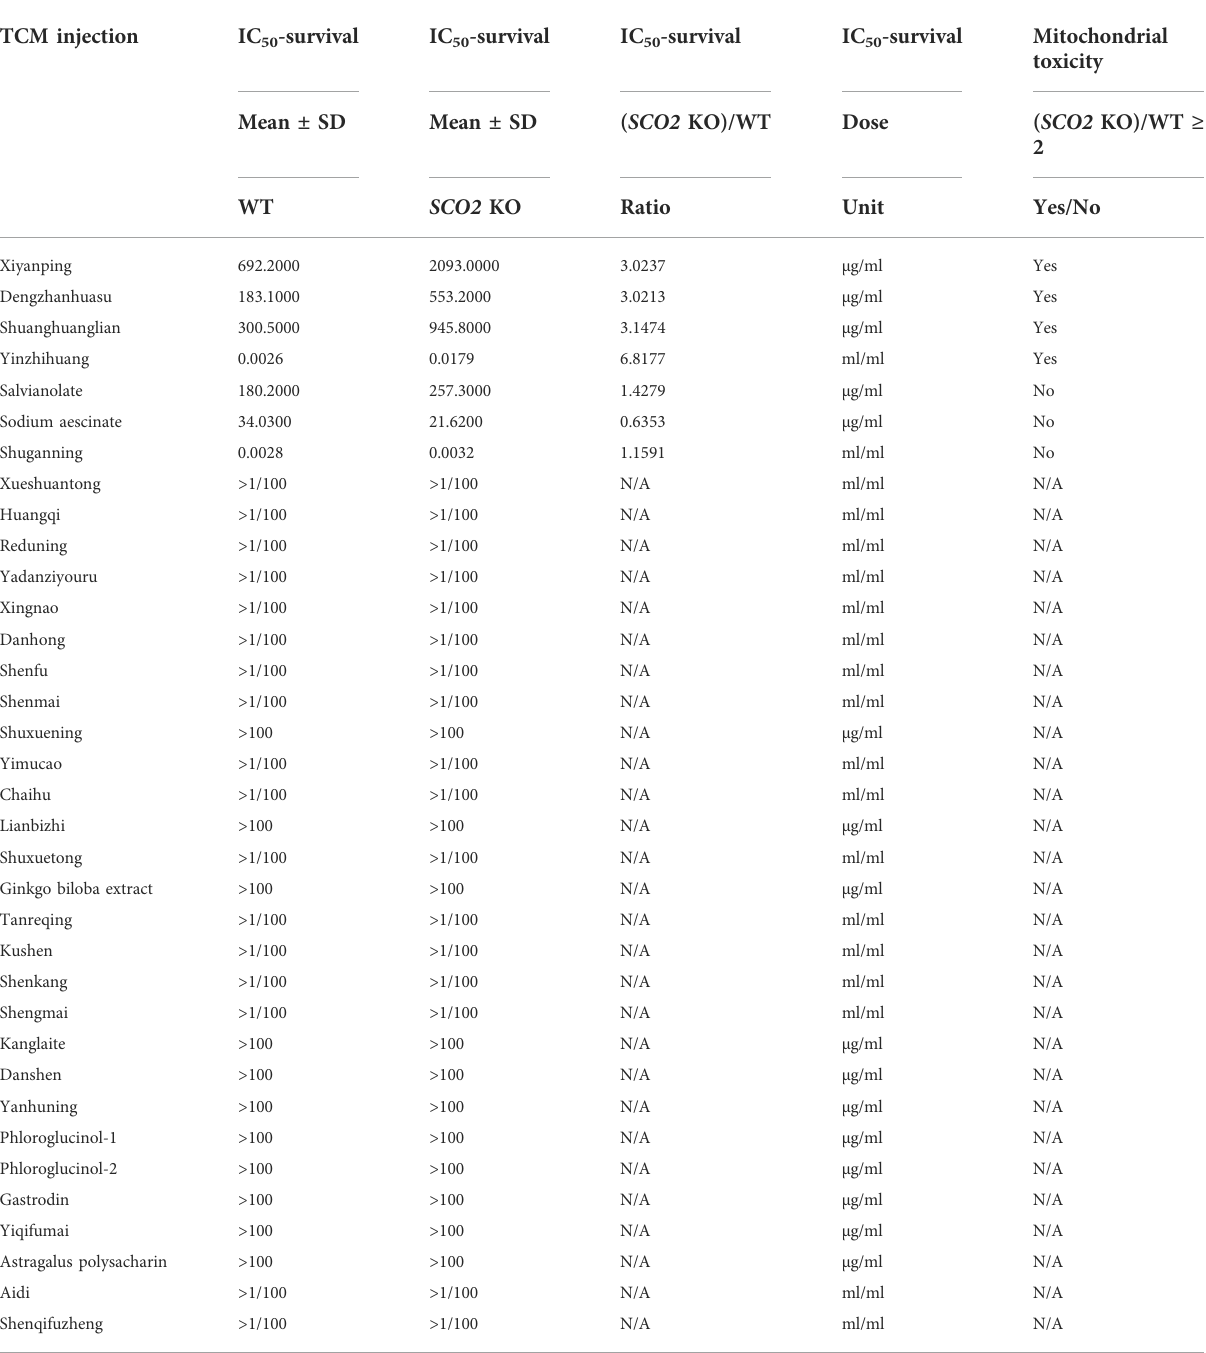
TABLE 2 The cytotoxicity of TCM injections in HCT116 (WT, SCO2 KO) cells. TCM